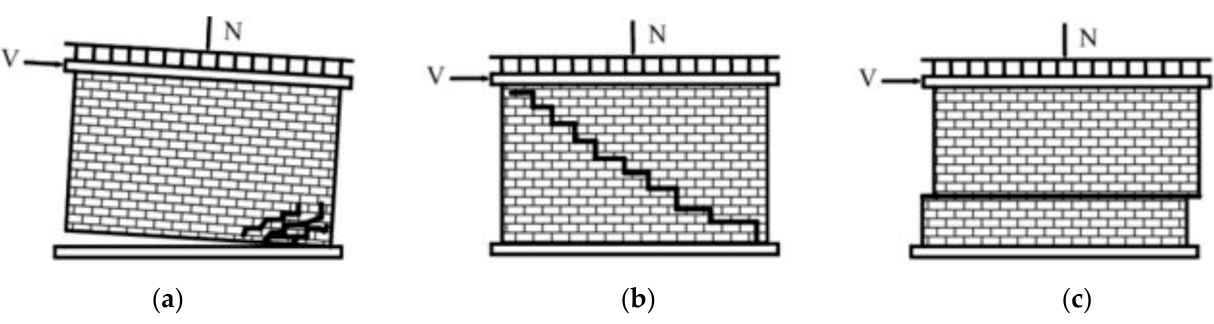
Figure 6. Crack patterns in UnReinforced Masonry (URM) walls: ( a ) rocking failure; ( b ) diagonal cracking; ( c ) bed-joint sliding [7].